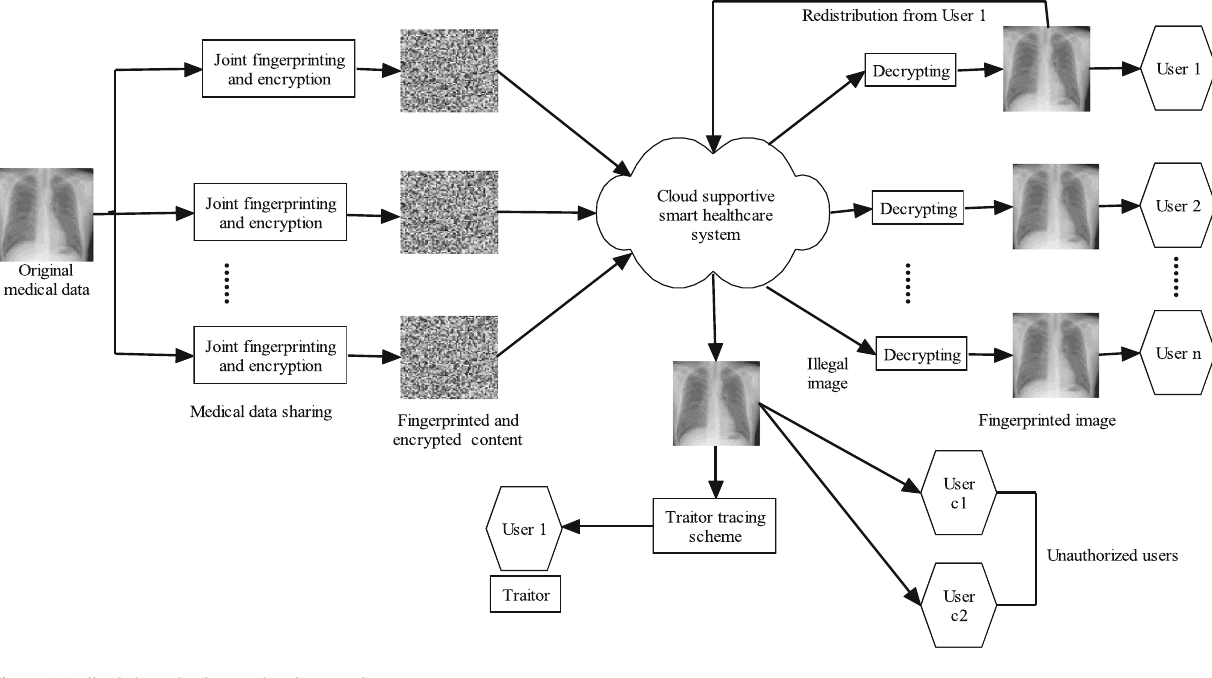
Fig. 2 Medical data sharing and traitor